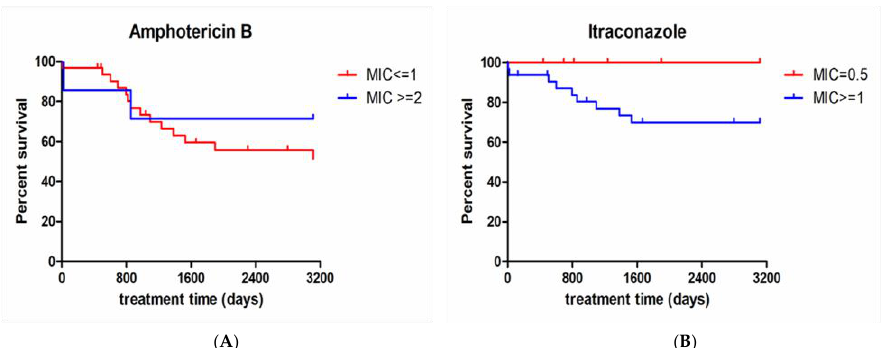
Figure 1. ( A ) Comparison between survival curves of patients presenting isolates with MIC ≤ 1 and MIC ≥ 2 for amphotericin B. p value = 0.455 (Mantel-Cox test). ( B ) Comparison between survival curves of patients presenting isolates with MIC = 0.5 and MIC ≥ 1 for itraconazole. p value = 0.194 (Mantel-Cox test); MIC (µg/mL).